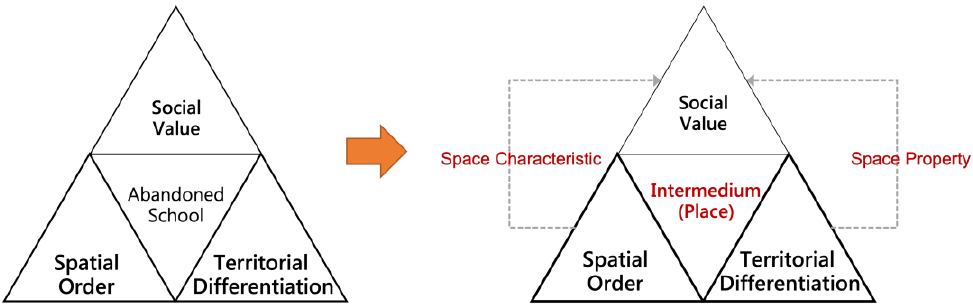
Figure 4. Scope of Redesign Development Study.